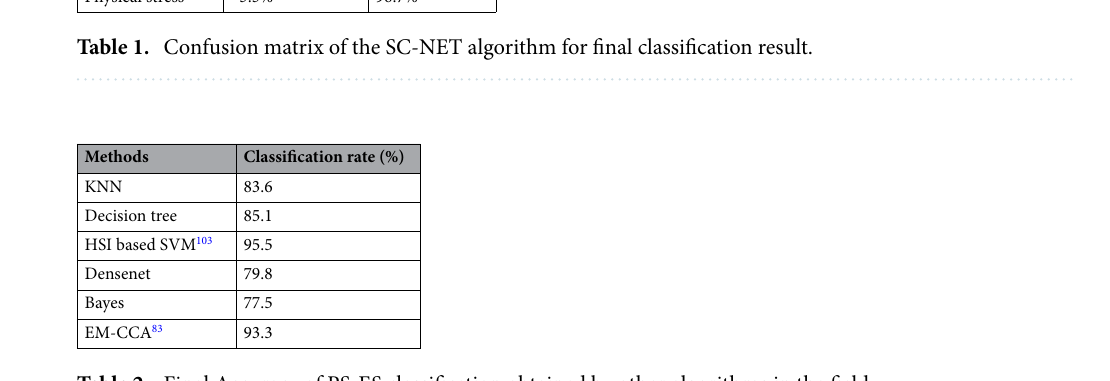
Table 2. Final Accuracy of PS-ES classification obtained by other algorithms in the field.